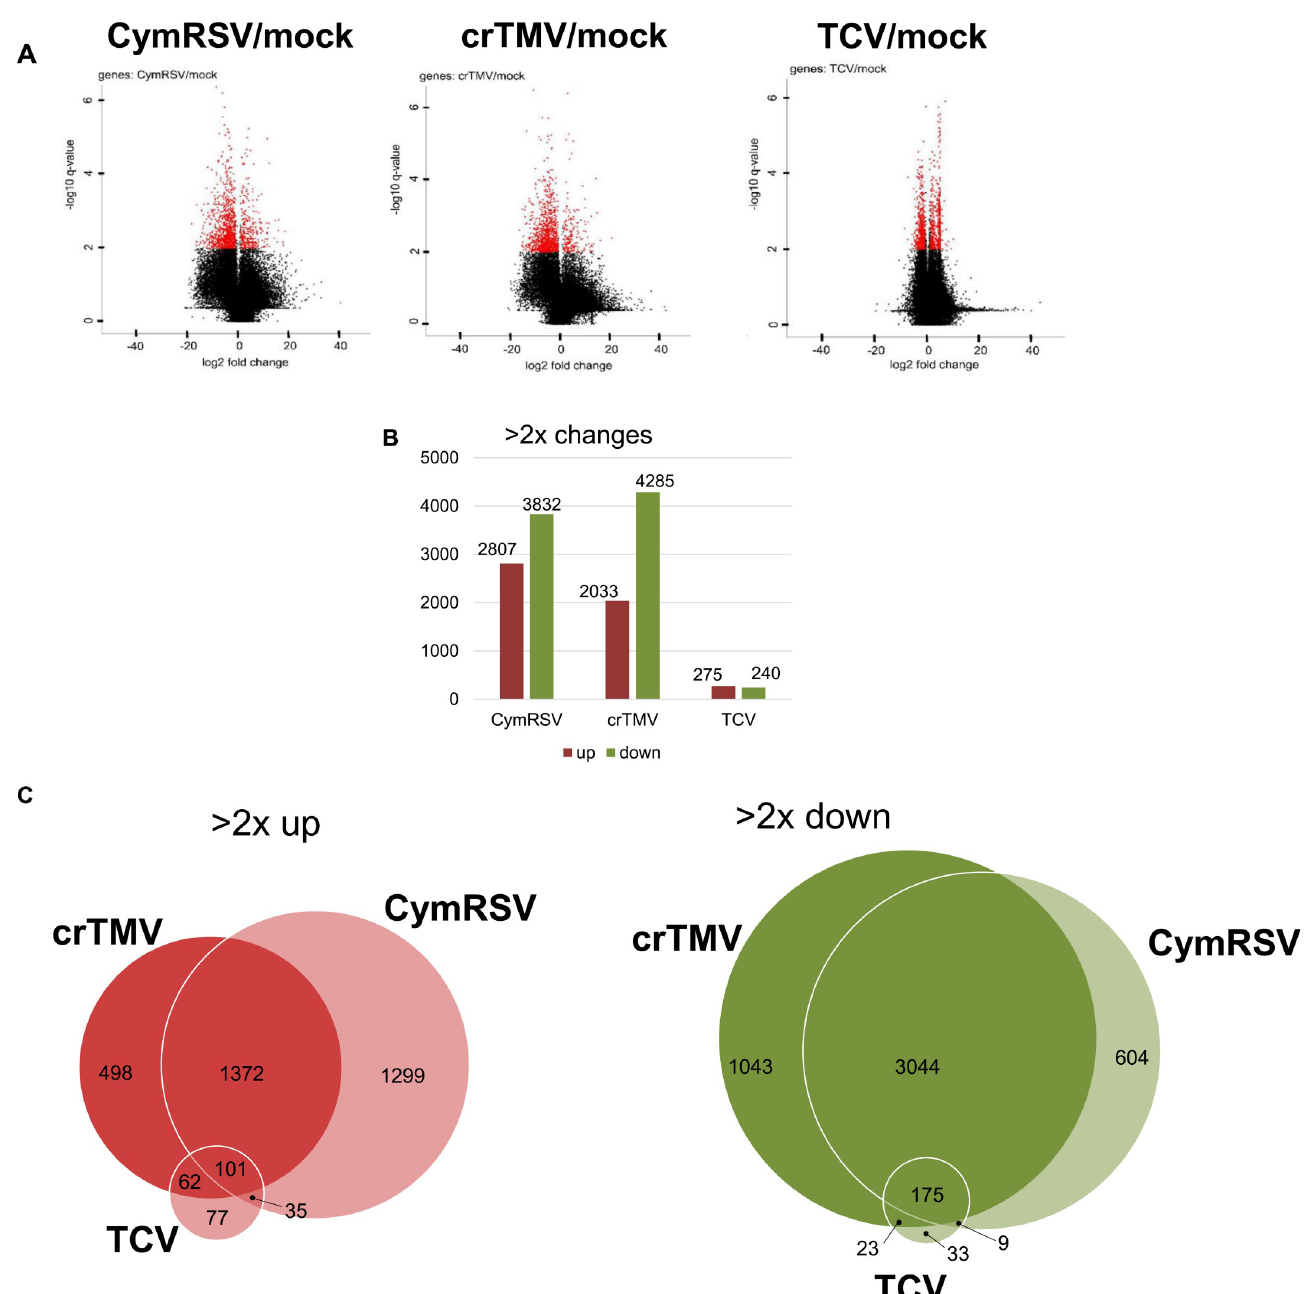
Fig 1. Gene expression changes in virus-infected N . benthamiana plants. Differentially expressed probes were obtained by comparing the gene expression of virus-infected and mock-treated samples. Fold changes in log2 were used to generate volcano plots. More than 2-fold changes and p values less than 0.05 were applied to identify the DEPs. (A) Volcano plots display log2-fold changes and p values. (B) Column diagram of the number of DEPs showing at least a 2-fold change. (C) Venn diagrams of DEPs identified in the virus-infected samples. Circle areas reflect the number of DEPs. All DEPs are listed with their characteristic parameters in S1